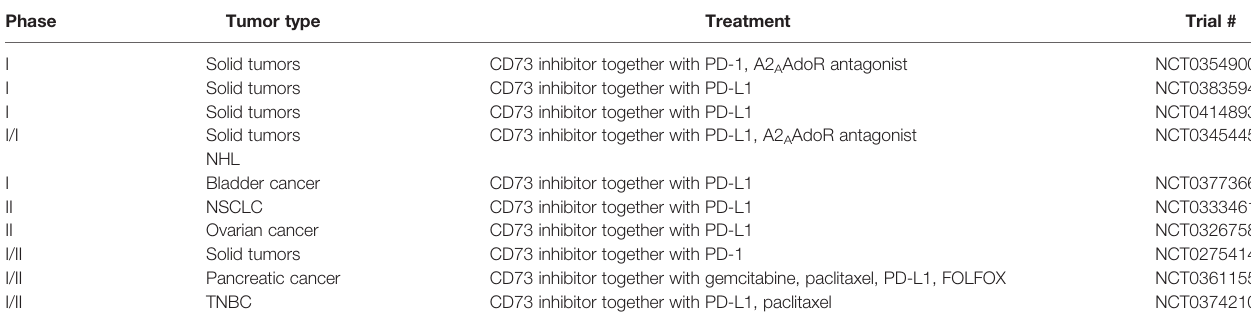
TABLE 1 | Current clinical trials targeting